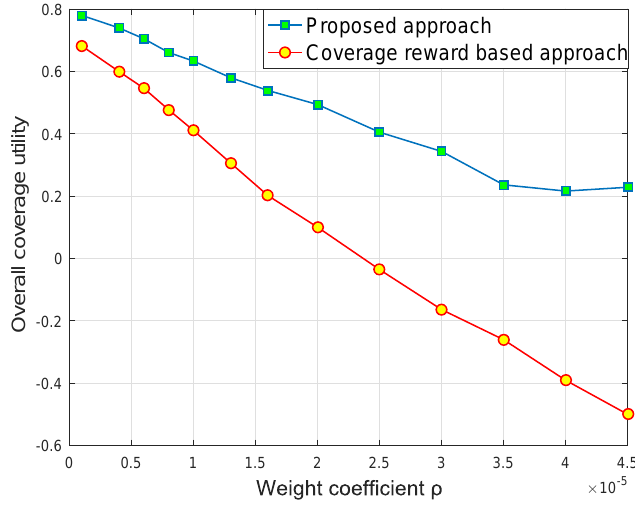
Figure 4. Overall coverage utility U 1 in UAV network.